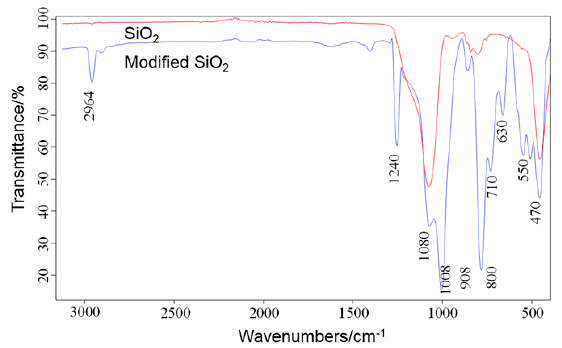
Figure 4. ATR-FTIR (attenuated total reflection Fourier-transform infrared spectroscopy) image of SiO 2 and modified SiO 2 particles.